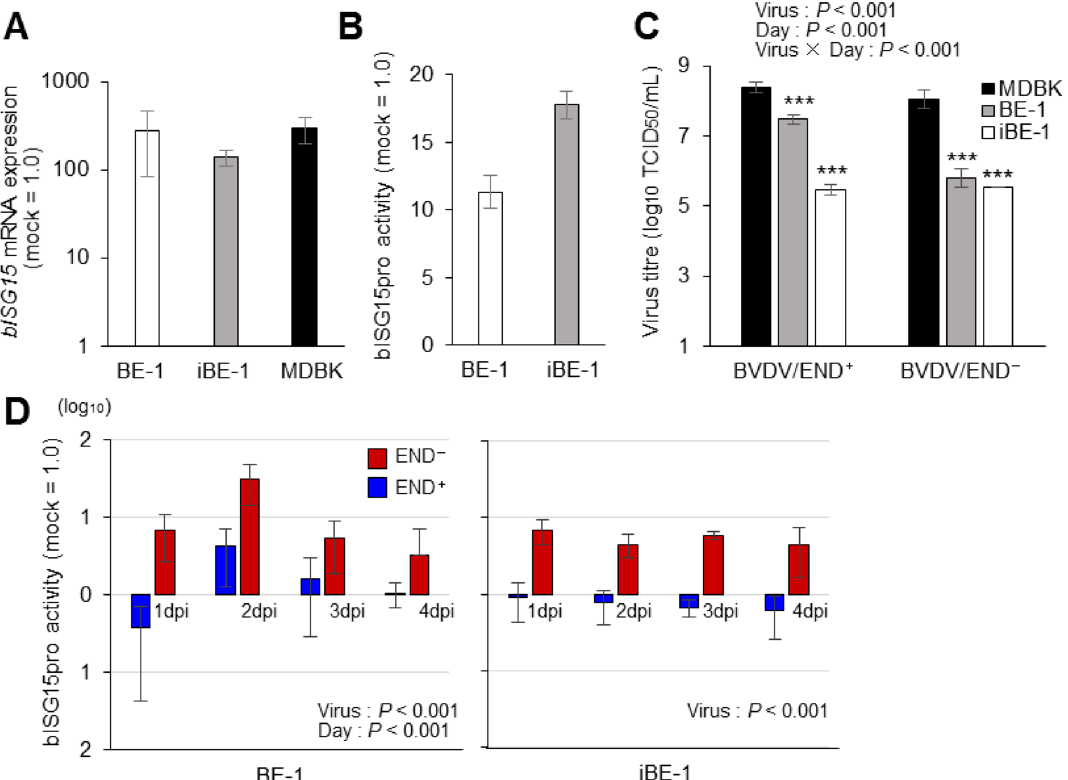
Figure 6. Applications of BE-1 and iBE-1 cells. ( A ) The expression of bISG15 mRNA in BE-1, iBE-1 and MDBK cells was measured by qPCR, 24 h after hrIFN-α (10 ng) treatment. No significant differences were observed in comparison with MDBK cells. ( B ) Reporter plasmids were introduced into BE-1 and iBE-1 cells, using the TransFectin Lipid Reagent, and hrIFN-α (10 ng) was added to the transfected cells at 24 hpt. Luciferase activities were measured 24 h after hrIFN-α stimulation. ( C ) To investigate the susceptibility of BE-1 and iBE-1 cells to BVDVs, BVDV/END + and BVDV/END – were inoculated into these cells, at an MOI of 1.0. MDBK cells were used as the positive control. Viral titres were calculated using a peroxidase-linked assay, with a pestivirus-specific antibody. Statistical analysis was performed for each virus type and compared with the titres calculated in MDBK cells. ( D ) Reporter plasmids were introduced into BE-1 and iBE-1 cells, and BVDV/END + or BVDV/END – was inoculated into the cells at 24 hpt. Luciferase activities were measured 1 ‒ 4 days after viral inoculation, and bISG15 promoter activities were